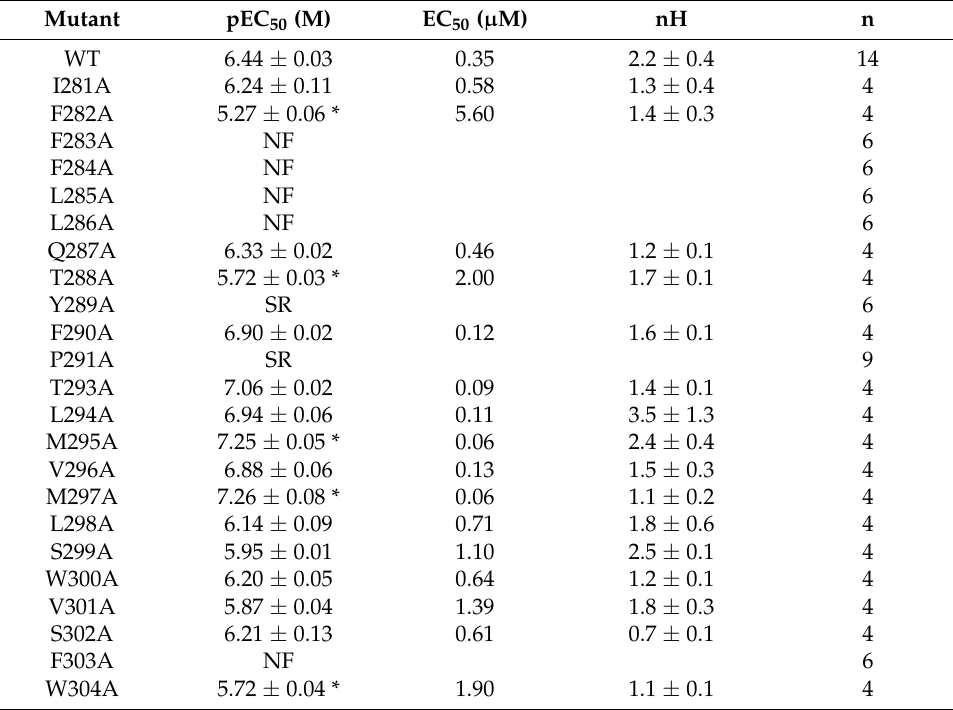
Figure 1. Responses of GABA A ρ 1R expressed in HEK293 cells. ( A – C ) Typical fluorescent responses (fluorescence in arbitrary units, AU) on addition of GABA (0.03–30 µ M) at 20 s to cells expressing WT or mutant GABA A ρ R. ( D ) Concentration–response curves; data = mean ± SEM, n ≥ 4. Table 1. Parameters from concentration – response curves after Ala substitution of M1 helix residues.